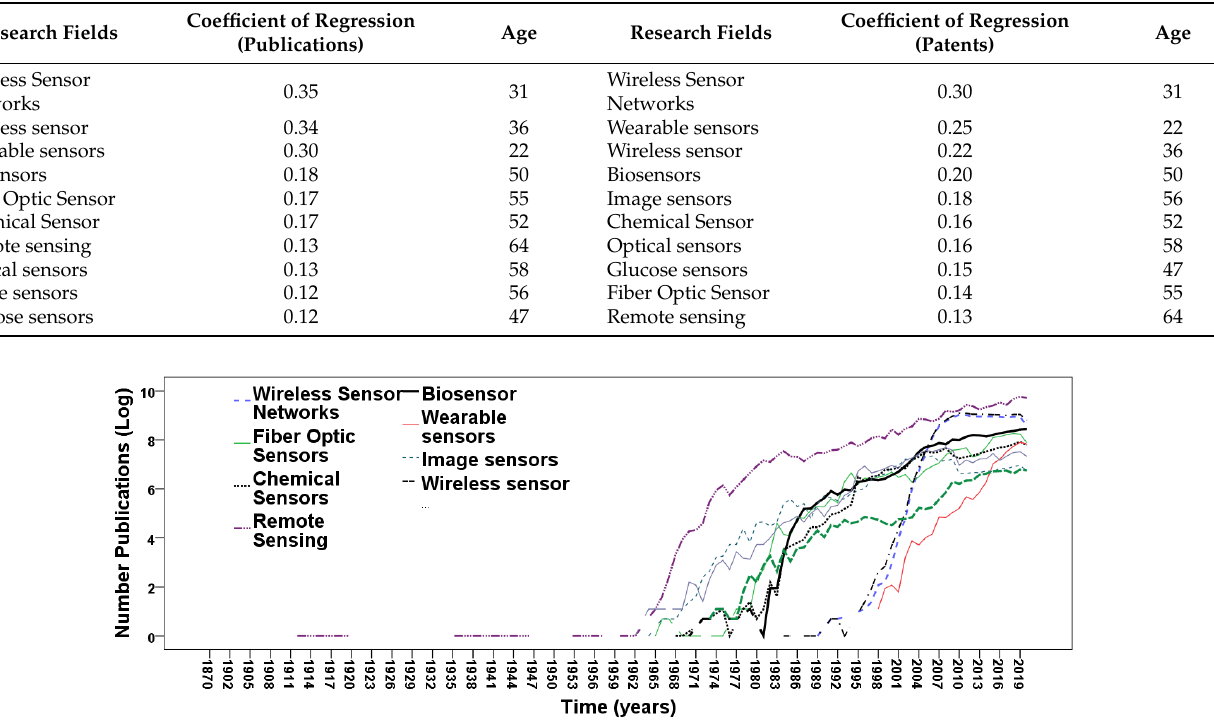
Table 3. Evolutionary growth of scientific fields in sensor technology considering the coefficients of regression based on number of publications and patents over time, and their scientific age from the first scientific products published to the year 2020.